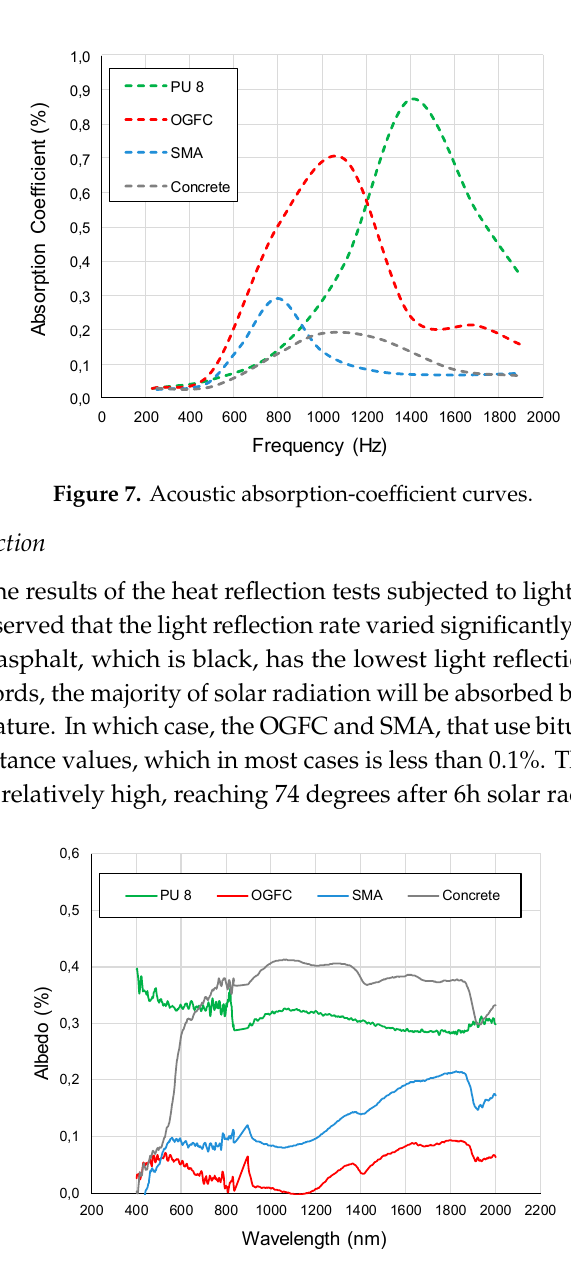
Figure 8. Simulation of solar radiation using iodine tungsten lamp.